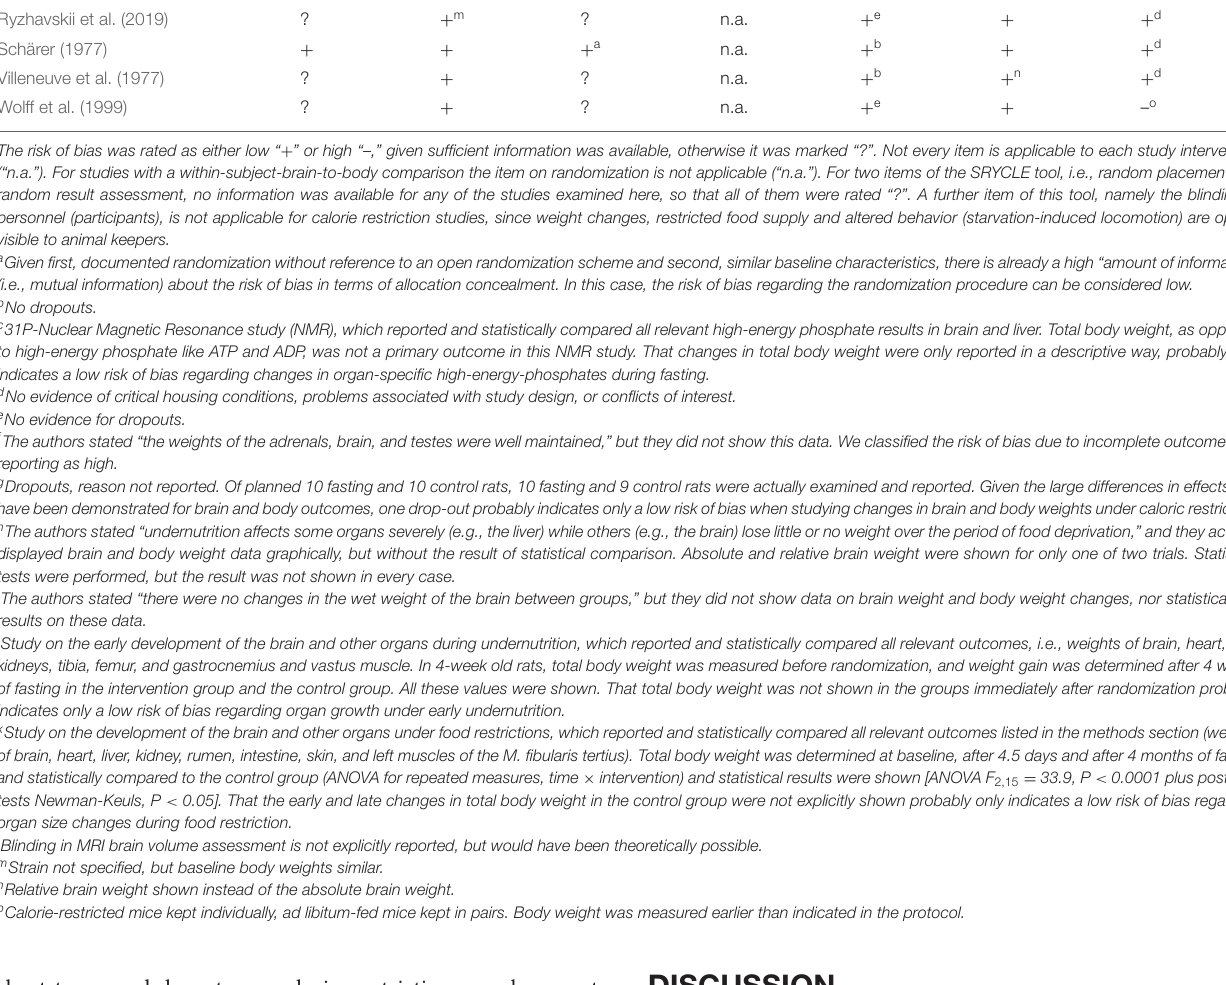
Random sequence generation